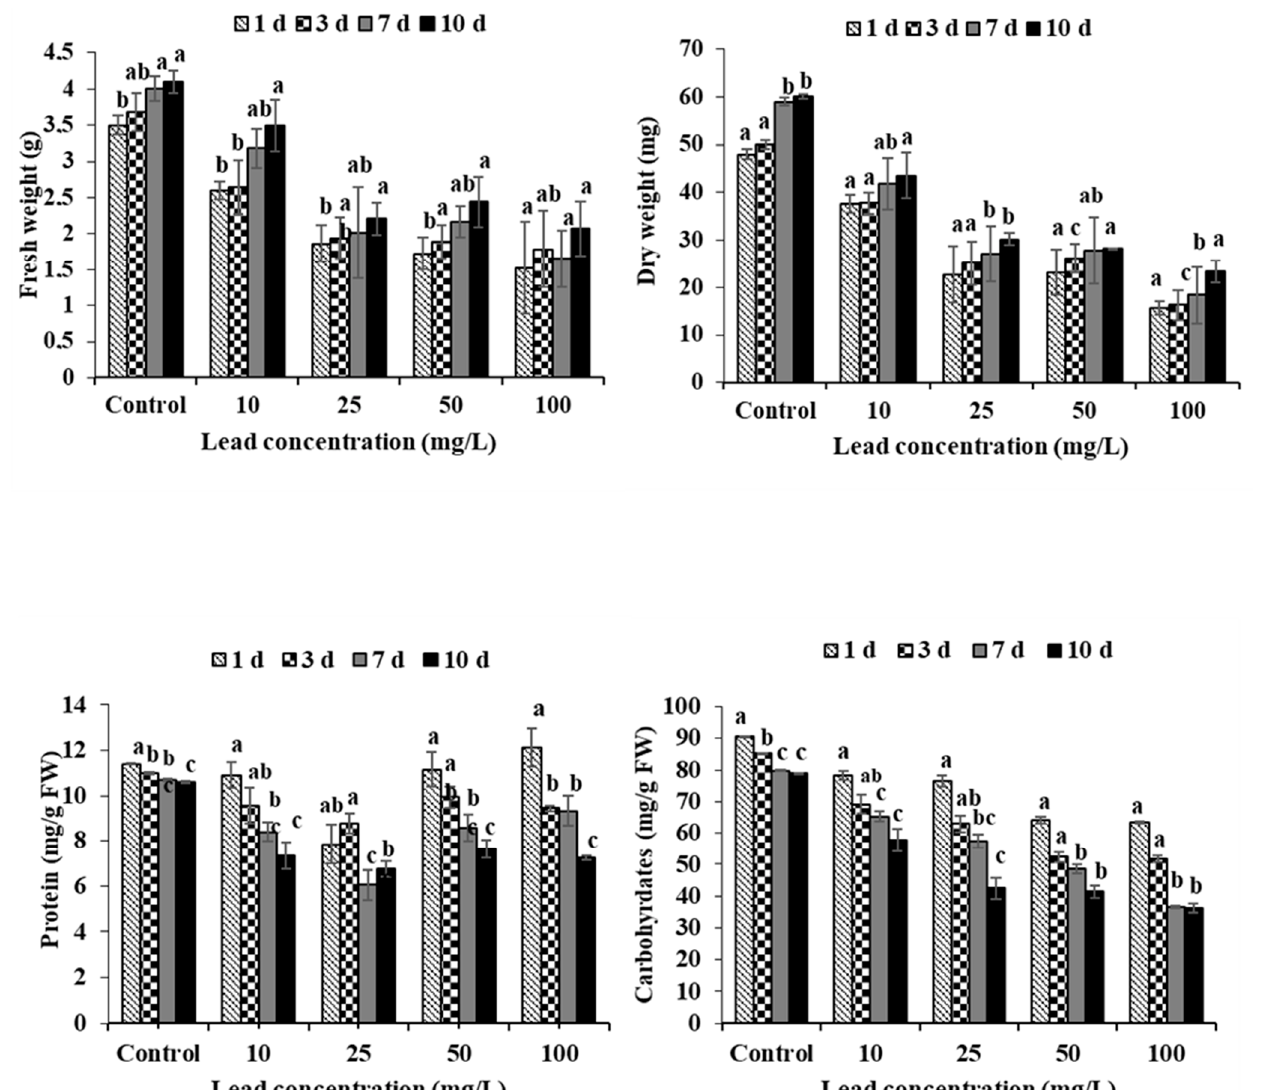
Figure 3. Effects of lead toxicity on fresh weight (g), dry weight (mg), protein content, and soluble carbohydrate concentration of Ludwigia stolonifera at different concentration and exposure times. Mean values ± SD ( n = 3). ANOVA was sig- nificant at p < 0.05. Different letters indicate significantly different values for a particular treatment group (Tukey’s p < 0.05).